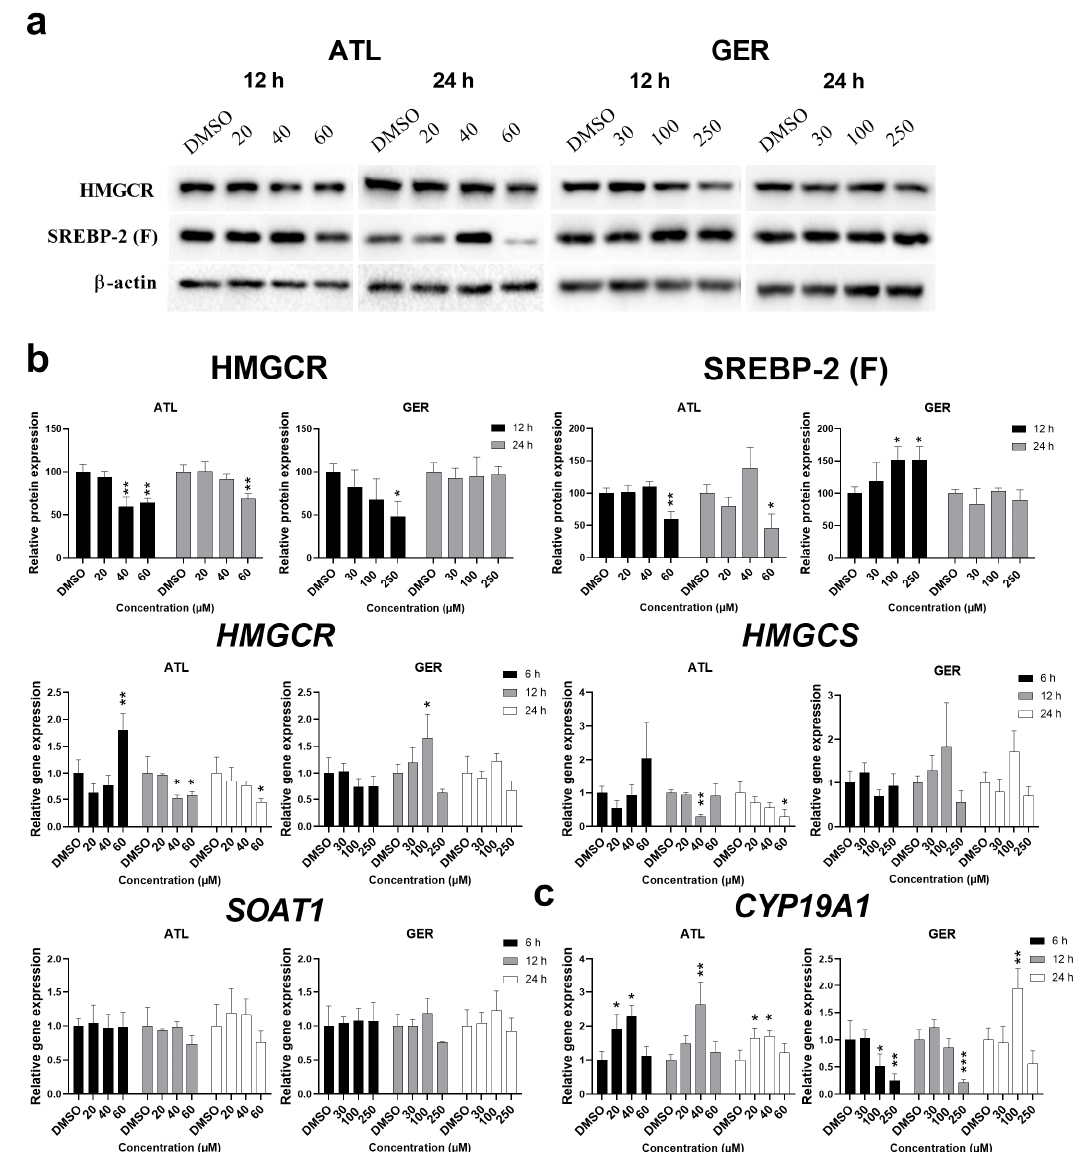
Figure 4. Expression changes in the targets predicted by the BATMAN-TCM after ATL and GER treatment of differentiated HepaRG cells. ( a ) Representative western blots showing expression changes on HMGCR and functional SREBP-2 (SREBP-2 (F)) proteins ( b ) Relative protein expression changes in HMGCR and SREBP-2 (F) after normalization to β -actin and relative gene expression changes in HMGCR , HMGCS and SOAT1 mRNA by RT-qPCR. ( c ) Relative gene expression changes in aromatase CYP19A1 mRNA by RT-qPCR after ATL and GER treatment. Results are expressed as the mean ± SD from three independent experiments. Results statistically significant: p < 0.05 (*), p < 0.01 (**), p < 0.001 (***).